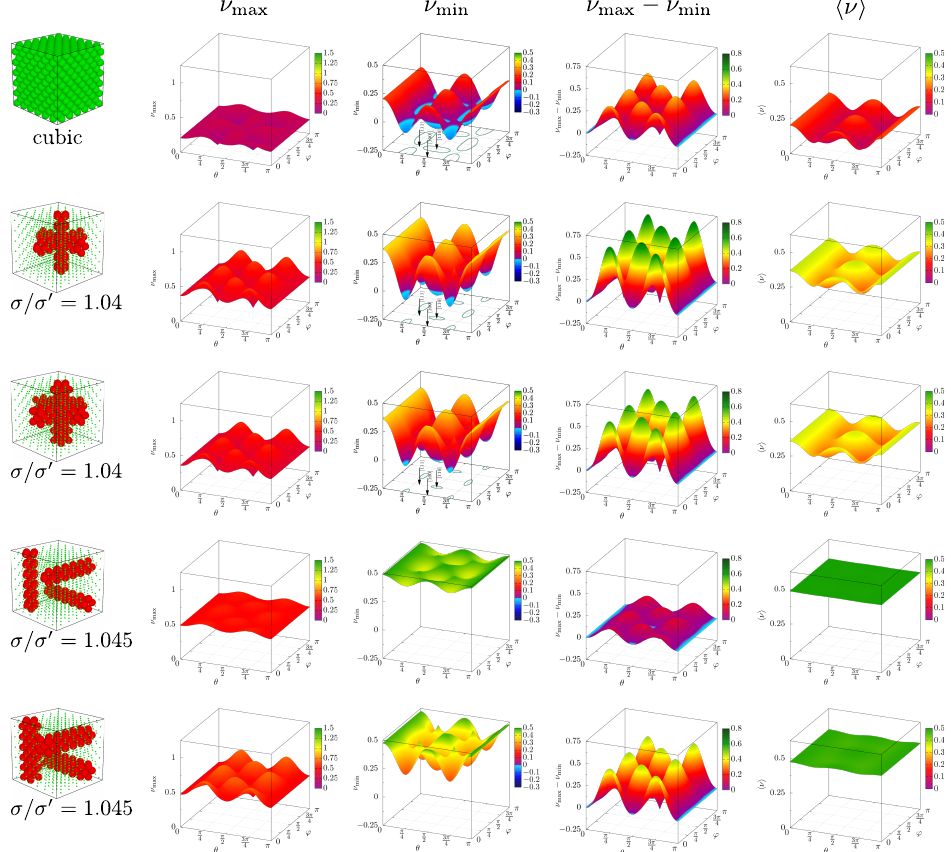
Figure 13. Surfaces composed of: maximal, minimal, their difference and the average PR (in respective columns) as a function of (cid:126) n -direction expressed by the polar and azimuth angles ( θ , ϕ ), presented for the cubic system and all the inclusion variants studied. The cases presented correspond to the data in Figure 12, for pressure p ∗ =